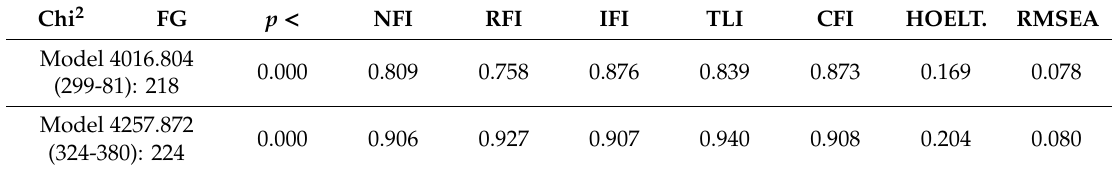
Table 6. Models of structural linear results of the variables.